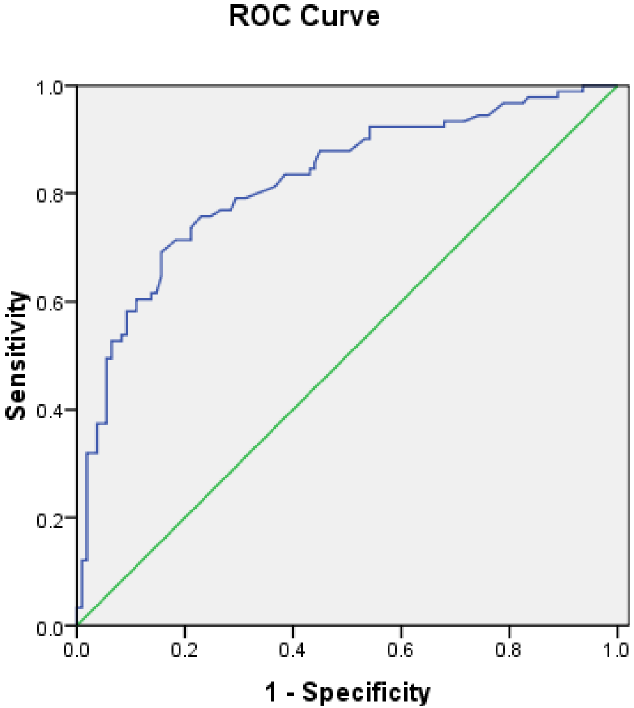
Fig 1. ROC curve provided by the model constructed to establish the predictive value for SVR. Area under the receiver-operating curve = 0.822 (95% CI = 0.76 – 0.88).